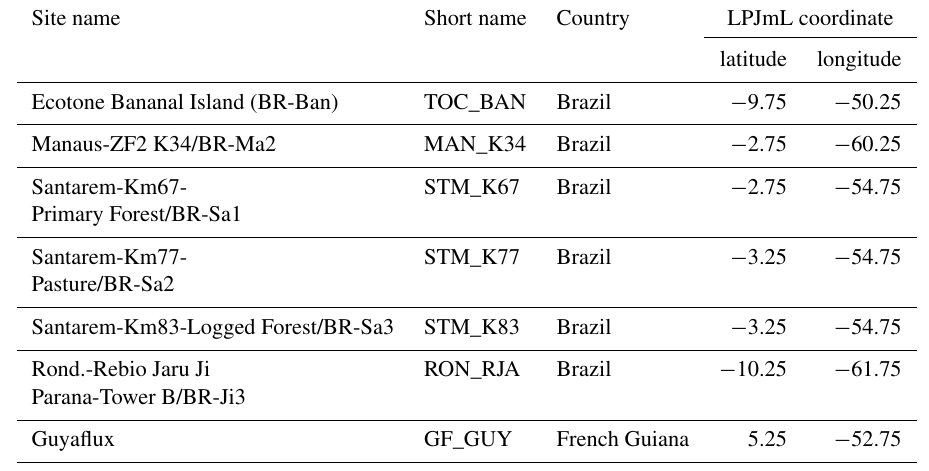
Table A3. Description of FLUXNET sites used for the evaluation of simulated ET.